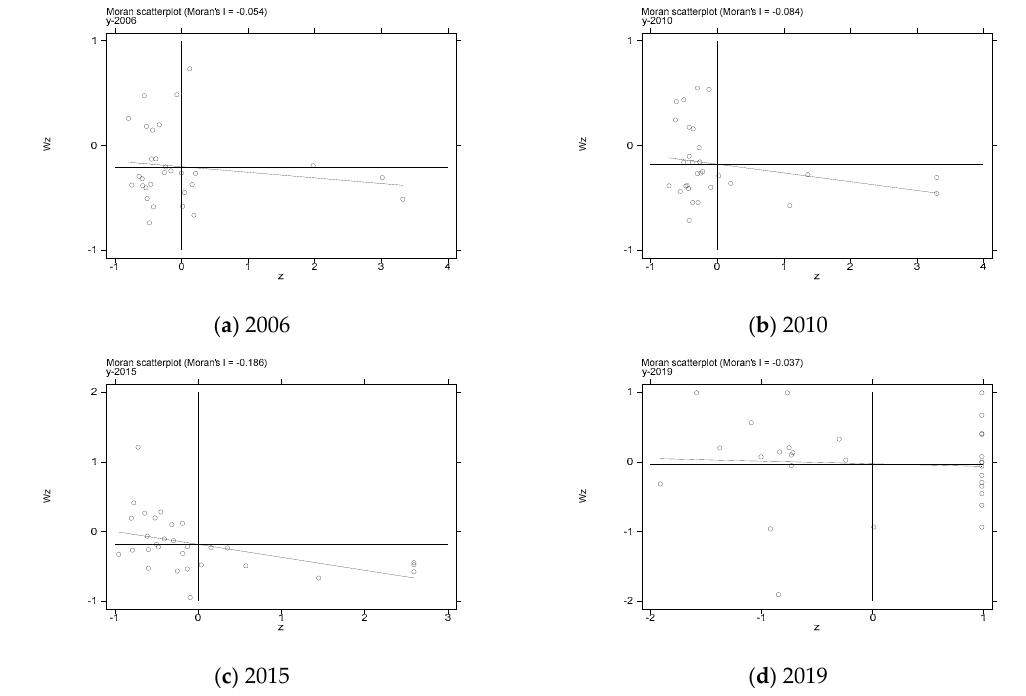
Figure 4. Moran scatter plot of tourism efficiency.